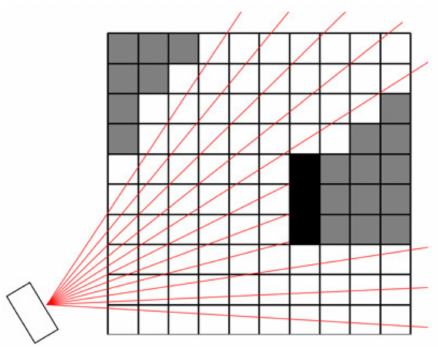
Figure 6. Using camera rays (red lines) to detect visible voxels in the grid; white voxels are visible, grey voxels are invisible, black voxels represent an obstacle.